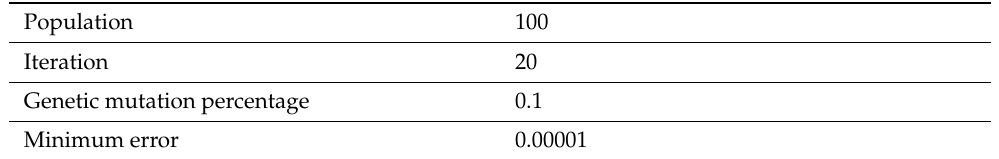
Table 2. GA Design Parameters.